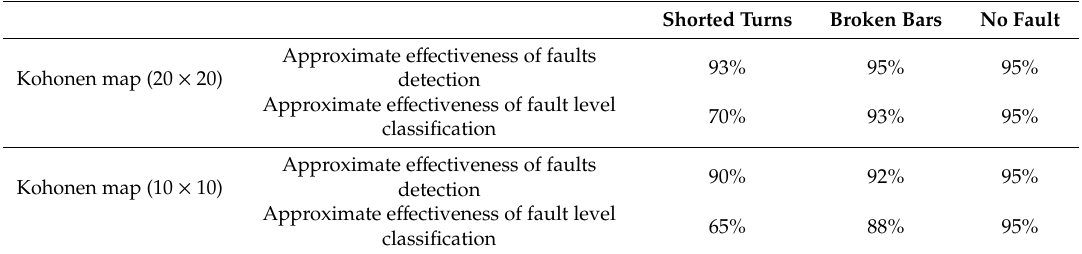
Table 2. E ff ectiveness of Kohonen network in fault detection and classification.